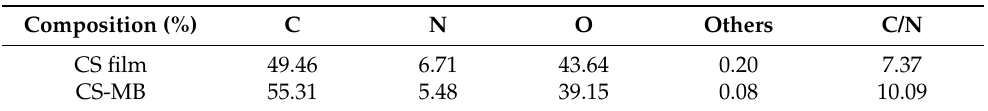
Table 2. Surface elemental analysis of CS-film and CS-MB by EDS (averaged between three different